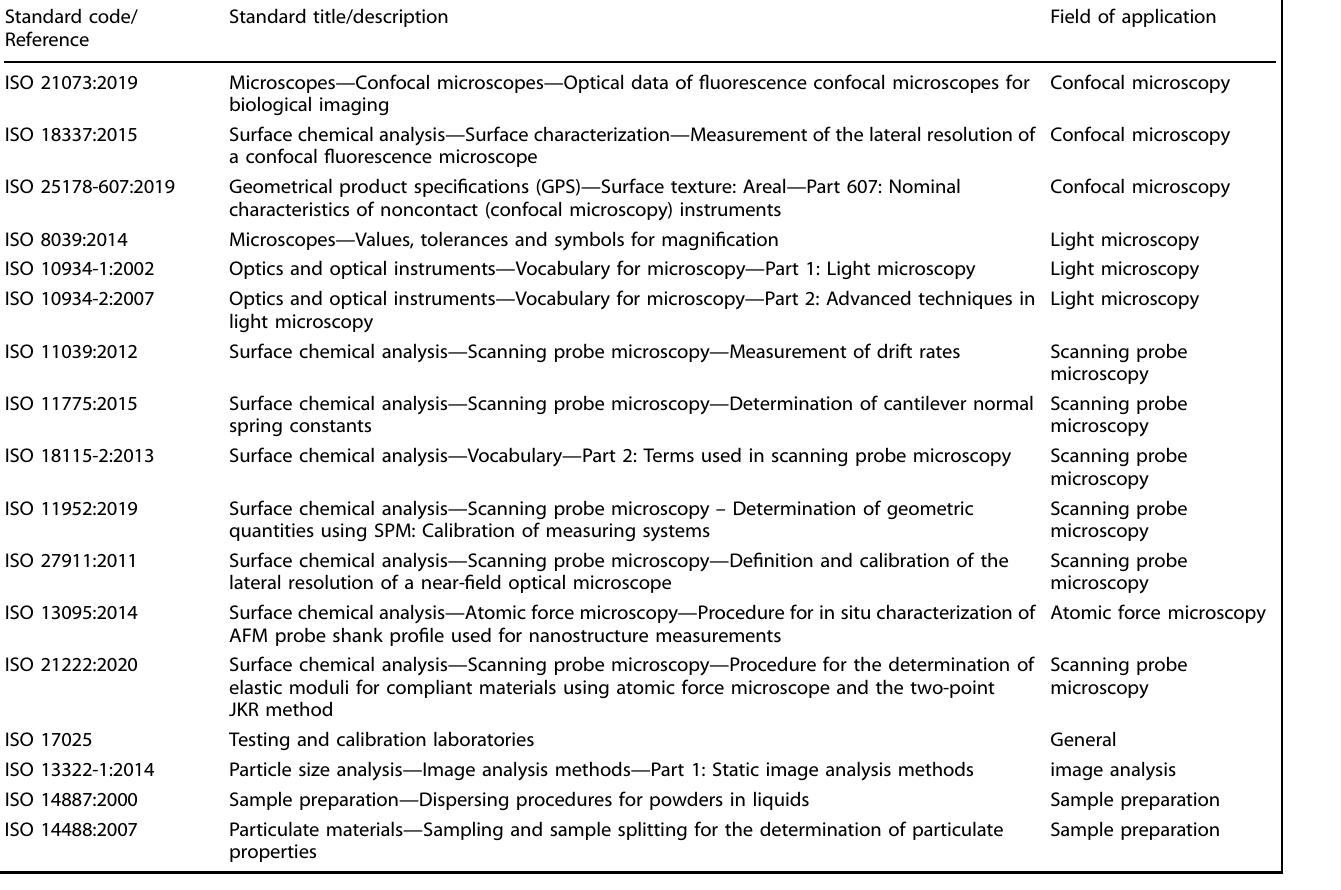
Table 4. List of standards applicable to different microscopy techniques and sample